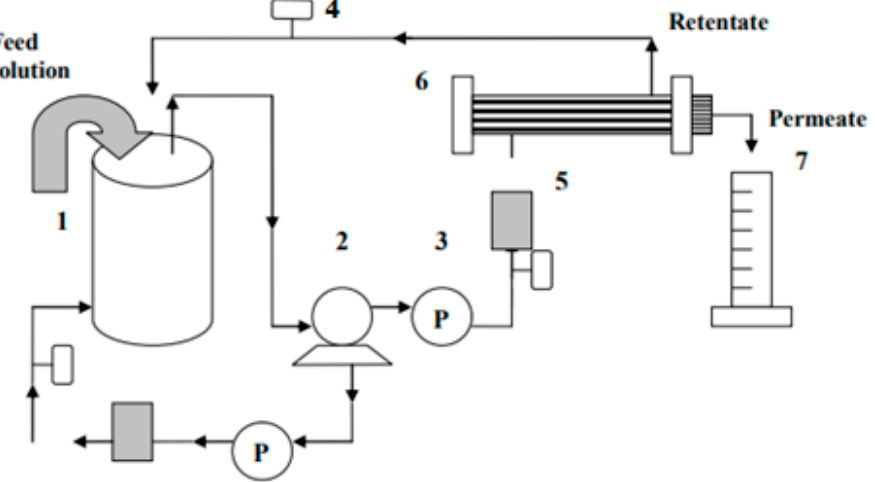
Figure 1. Ultrafiltration flat sheet membrane separation schematic diagram. (1) Feed tank; (2) pump; (3) pressure gauge; (4) control valve; (5) flow meter; (6) permeation test (flat sheet membrane module); (7) measuring cylinder.